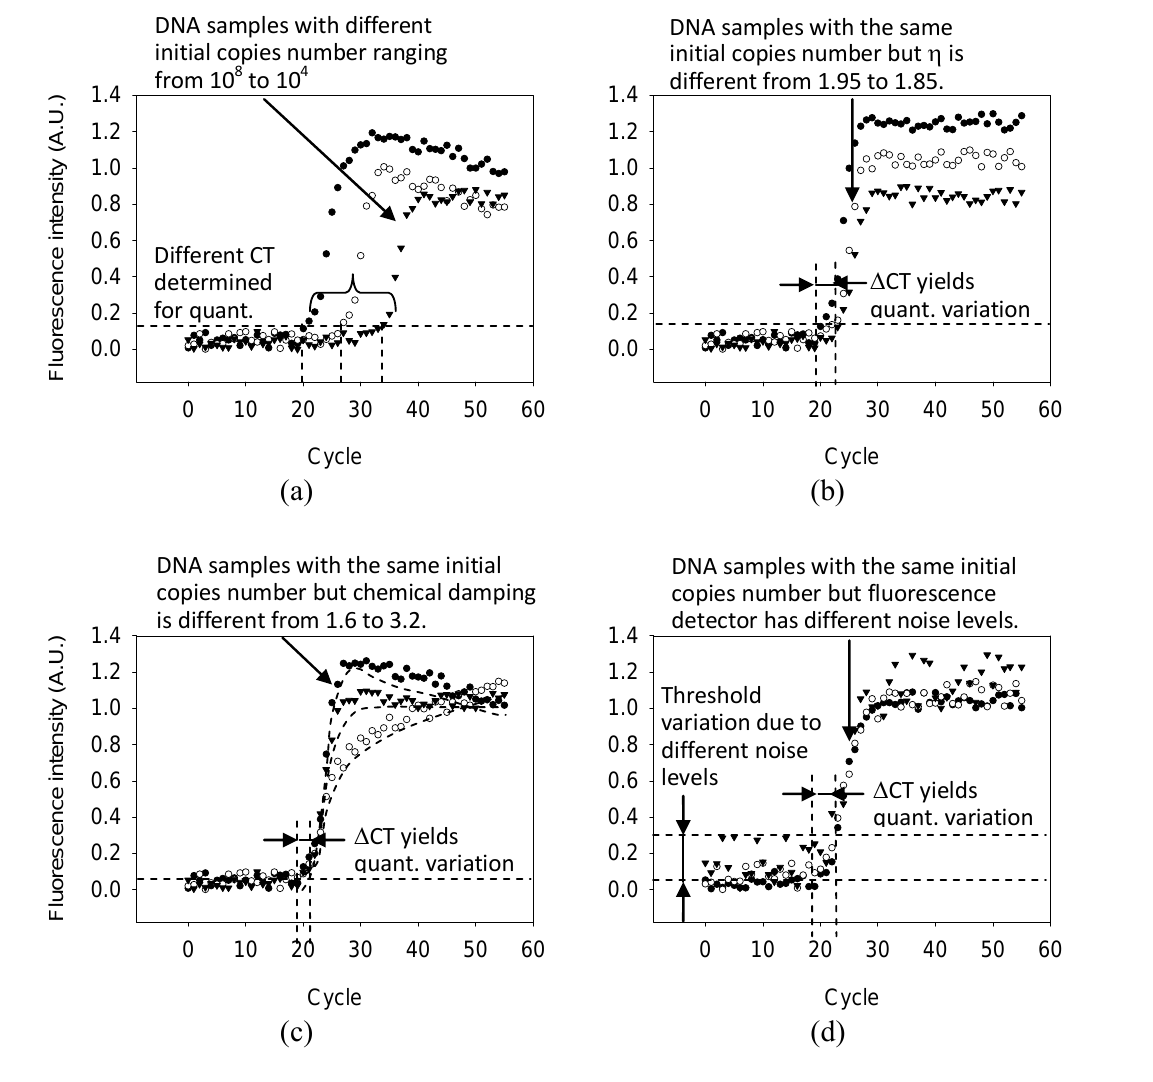
Figure 6. Simulation results of the real-time PCR machine: With respect to the samples of different initial copies number, the fluorescence intensity versus PCR cycle are simulated in (a). The fluorescence readings of each PCR cycle are randomly disturbed by the noise factors, including different amplification efficiency, chemical instability, and fluorescence detection noise level, and their effects are simulated in (b), (c) and (d). All three factors have an impact on the reproducibility of DNA quantification (extracted by quant.) by the variation of the threshold cycle